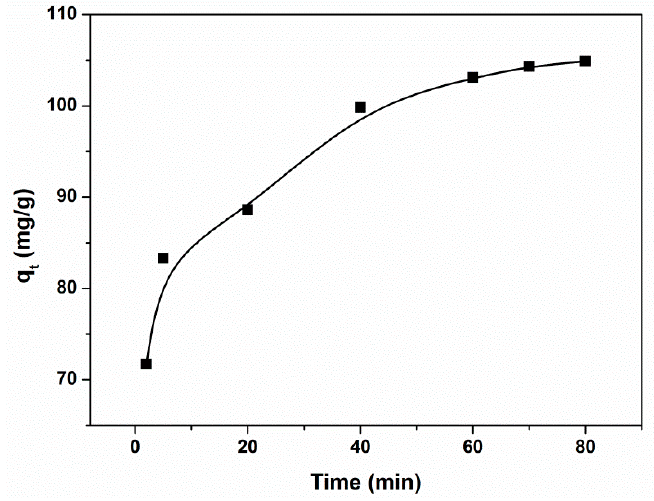
Figure 6. Adsorption kinetics of CR in aqueous solution on the magnetic PGMA-g-PPy. (Adsorbent dose, 237 mg; volume, 50 mL; initial concentration, 500 mg/L; pH, 7.0.)